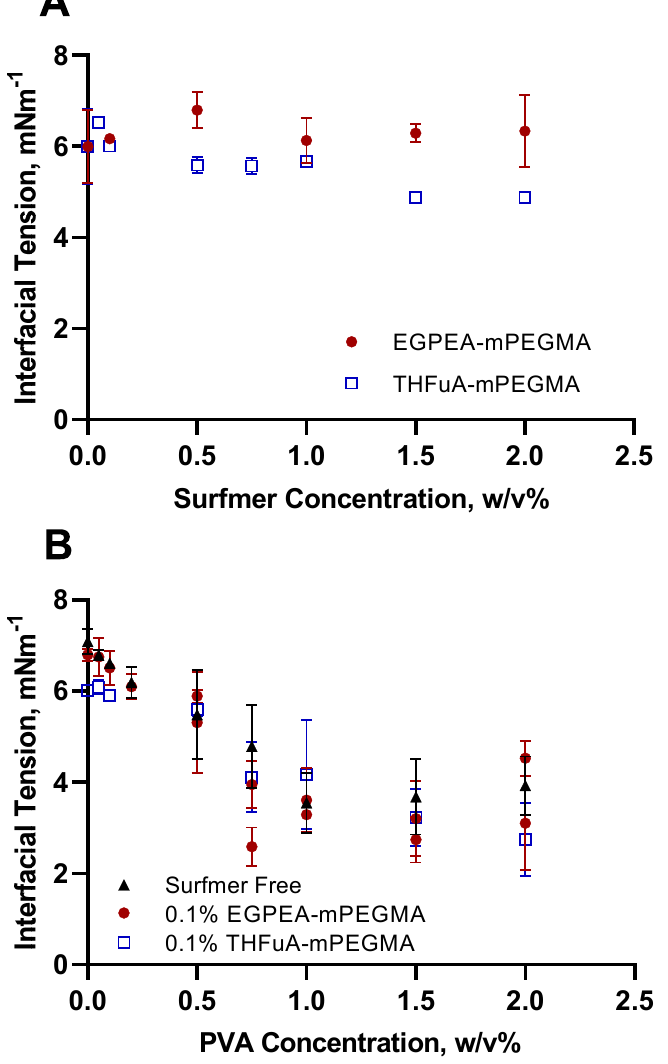
Figure 2. Interfacial tension of PDLLA (5% ( w / v )) in ethyl acetate against water with the addition of ( A ) EGPEA-co-mPEGMA or THFuA-co-mPEGMA in increasing concentrations to the dispersed phase; ( B ) no surfmer or a fixed concentration of EGPEA-co-mPEGMA or THFuA-co-mPEGMA with increasing PVA concentration in the continuous phase. Error bars equal ± 1 SD unit, n = 3–4. In order to obtain the necessary droplet stability, PVA was then added into the water phase. The data in Figure 2B show the effect of adding PVA to the continuous phase with both no surfmer and with fixed concentrations (0.1% ( w / v )) of individual surfmers in the dispersed phase. PVA delivered a significant reduction in interfacial tension as the con- centration increased from 0% to 2%, both with and without the presence of a bespoke surfmer. Common concentrations of PVA in the water phase used in microparticle for- mation are between 0.5% and 2% ( w / v ). From the trend in Figure 2B, the optimum concen- tration to minimise the interfacial tension was between 1% and 1.5% ( w / v ) PVA. However, to preserve the desired surface chemistry, the PVA concentration needed to be minimised.